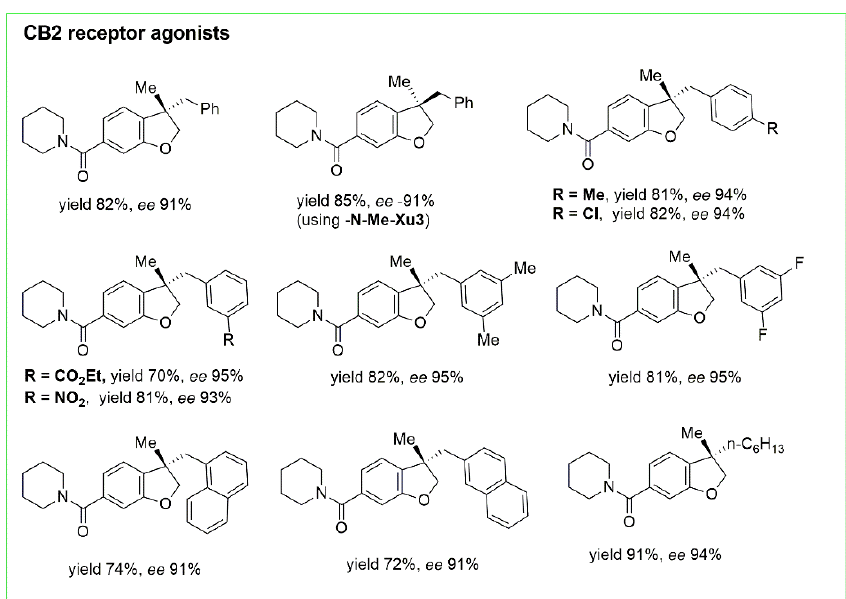
Figure 33. CB2 receptor agonists obtained with synthesis in Figure 32.